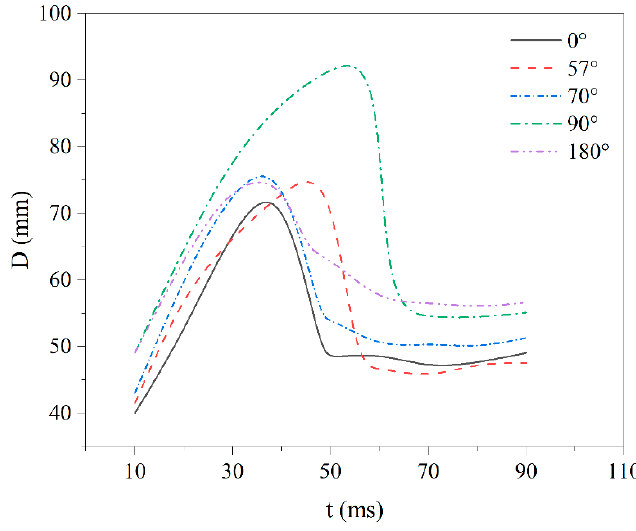
Figure 26. Hydrophobic model vacuolar diameter–time curve (v = 3.95 m/s).